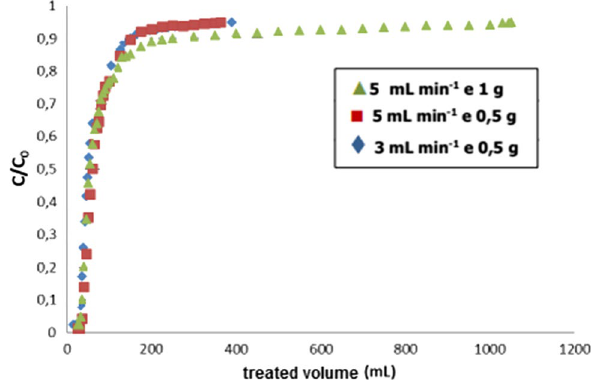
Fig. 7 Rupture curves of column by different operation parameters